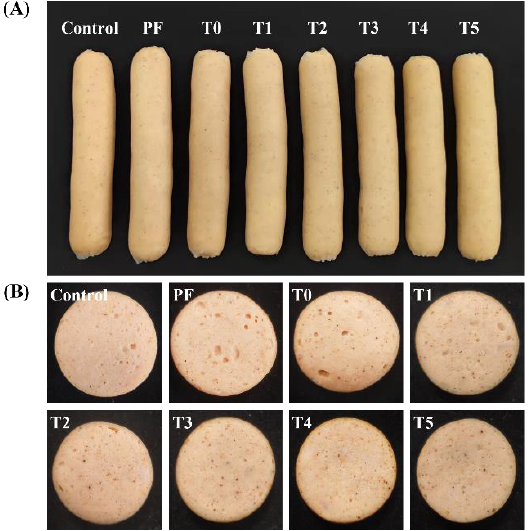
Figure 4. Images of phosphate-containing frankfurters or phosphate-free frankfurters added with the combination of L-Arg and PC. ( A ) the entire frankfurters. ( B ) cross section of frankfurters. PF group: no added phosphate. T0 group: 0.15% PC and no added phosphate. T1 group: 0.15% PC + 0.025% L-Arg, and no added phosphate. T2 group: 0.15% PC + 0.05% L-Arg, and no added phosphate. T3 group: 0.15% PC + 0.075% L-Arg, and no added phosphate. T4 group: 0.15% PC + 0.1% L-Arg, and no added phosphate. T5 group: 0.15% PC + 0.125% L-Arg, and no added